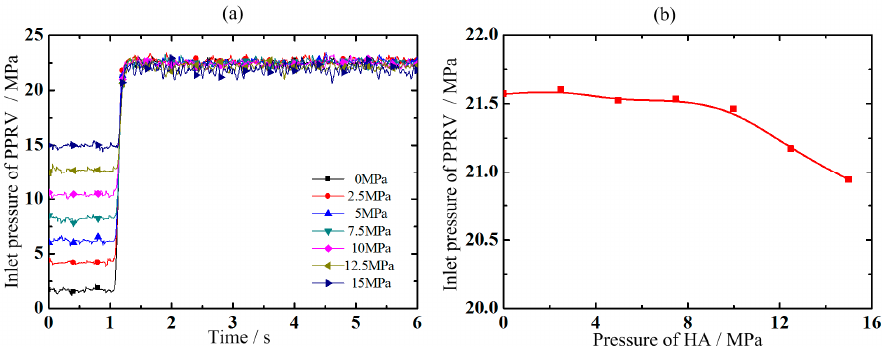
Figure 14. Experimental results with different maximum pressures of HA. ( a ) Inlet pressure of PRV; ( b ) Inlet pressure vs. maximum pressure of HA.